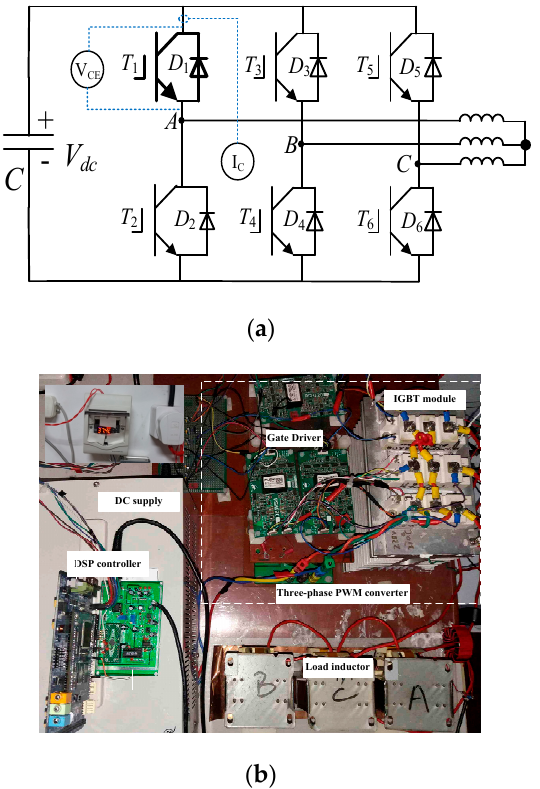
Figure 10. The PWM converter test for IGBT switching time monitoring: ( a ) schematic diagram; ( b ) picture of test rig.